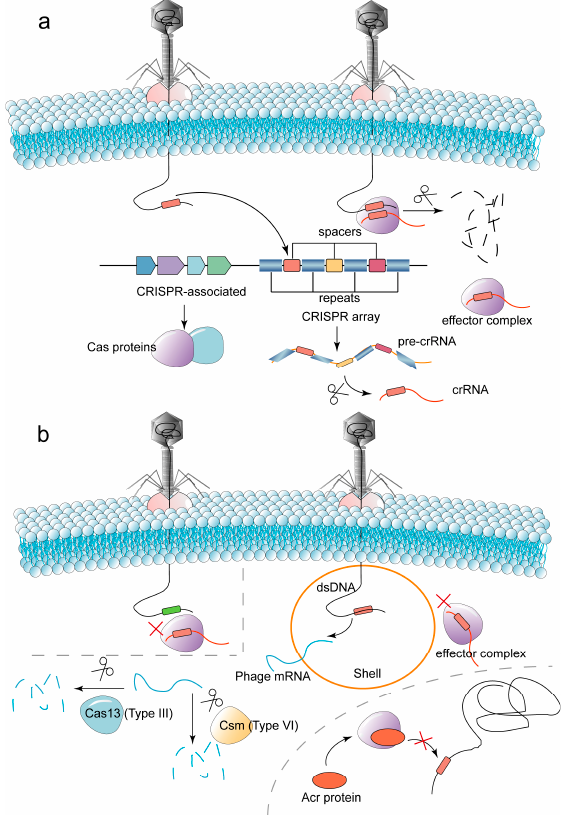
Figure 4. The arms race between bacteria and phages in terms of the CRISPR-Cas systems (the symbol red cross in the figure indicates that the recognition and cleavage of foreign genes by the effector complex is inhibited). ( a ) The CRISPR-Cas adaptive immune system consists of the CRISPR arrays and the cas genes. The effector complex of crRNA and Cas proteins targets and cleaves phage DNA/RNA. ( b ) Phages countermeasure against CRISPR-Cas, including mutating target sequences to block recognition of effector complexes; constructing nucleus-like compartments to shield nucleases; and expressing anti-CRISPR (Acr) to inhibit recognition of exogenous nucleic acids or impede cleavage of nucleic acids by Cas nucleases. Since phage mRNA expresses proteins in the bacterial matrix, phage mRNA can still be targeted and cleaved by type III and type VI CRISPR-Cas systems. Obviously, the more phage species, the more abundant and diverse spacers in the host genome, which is more conducive to the evolution of bacterial CRISPR-Cas systems. Additionally, the higher the content of CRISPR spacers, the more sensitive the bacteria to phages [64]. The increase in phage abundance is conducive to the increase in CRISPR-Cas abundance. Additionally, when the abundance of phages is constant, the phage species is inversely correlated with the abundance of CRISPR-Cas systems [65]. In addi- tion to phage diversity, bacterial species richness can also have an impact on the evolution of CRISPR-Cas systems. When there are infectious phages in the environment, the more